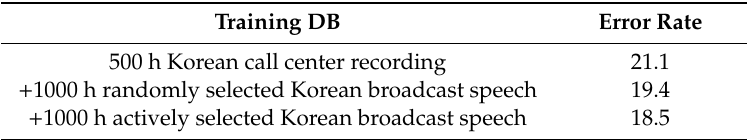
comparing the models trained using the speech DB selected by the proposed active learning method